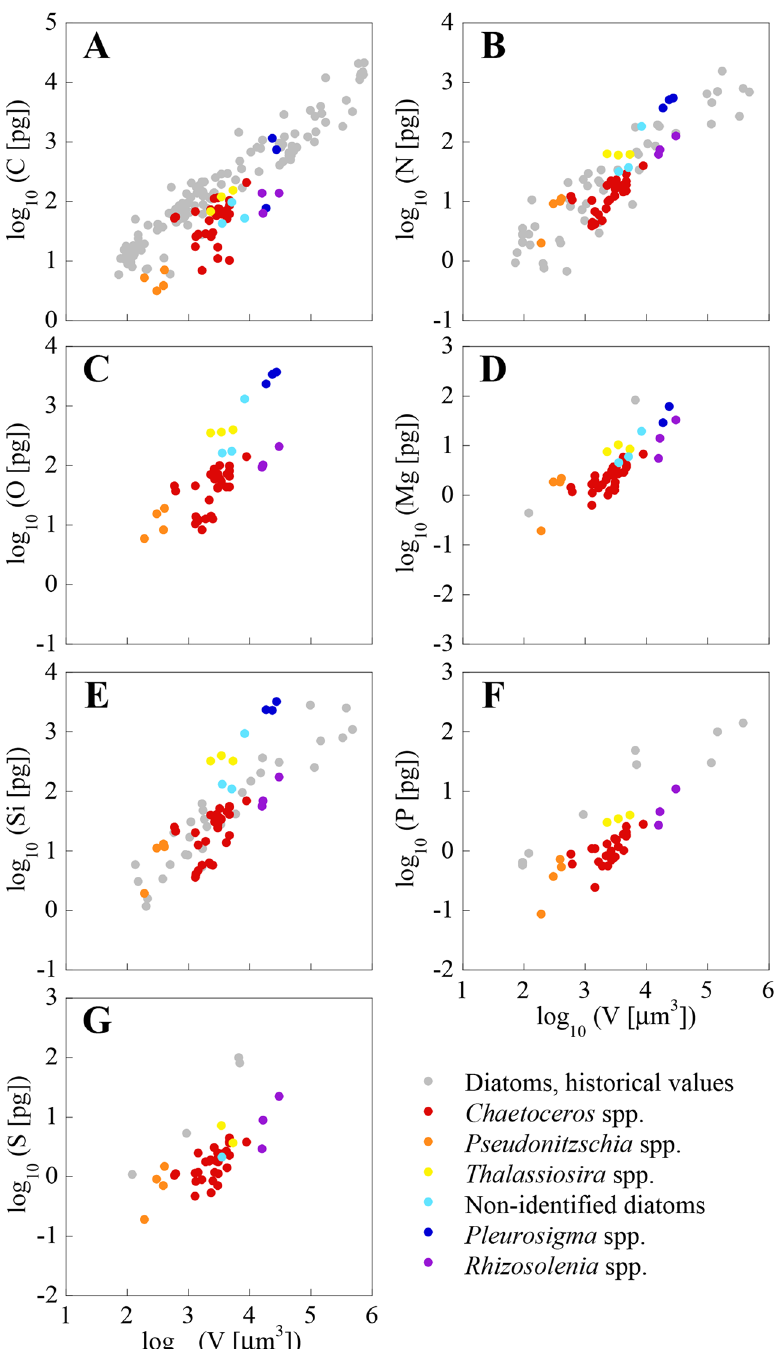
Fig 3. Log-log plots of the mass of C, N, O, Mg, Si, P and S (pg cell -1 ) vs . volume ( μ m 3 cell -1 ). Diatom single-cell values from the NW Mediterranean Sea are presented along with historical values of cultured diatom cells obtained using bulk analysis techniques. Note that vertical axes vary between